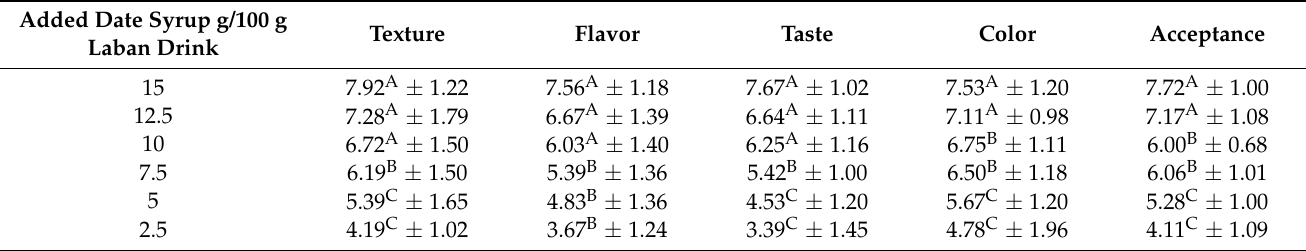
Table 1. Sensory evaluation of laban drinks at different added date syrup